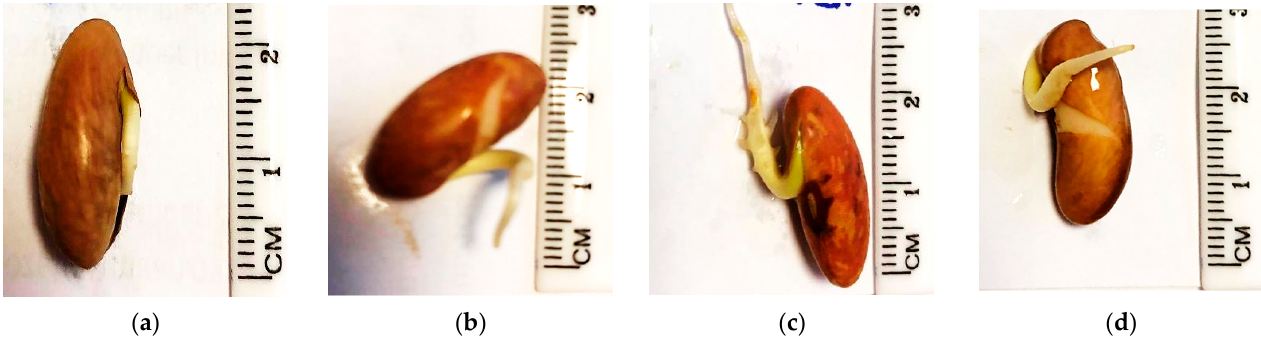
Figure 9. Bean seed radicle length after ( a ) 4 days and ( b ) 7 days of incubation at germination conditions.